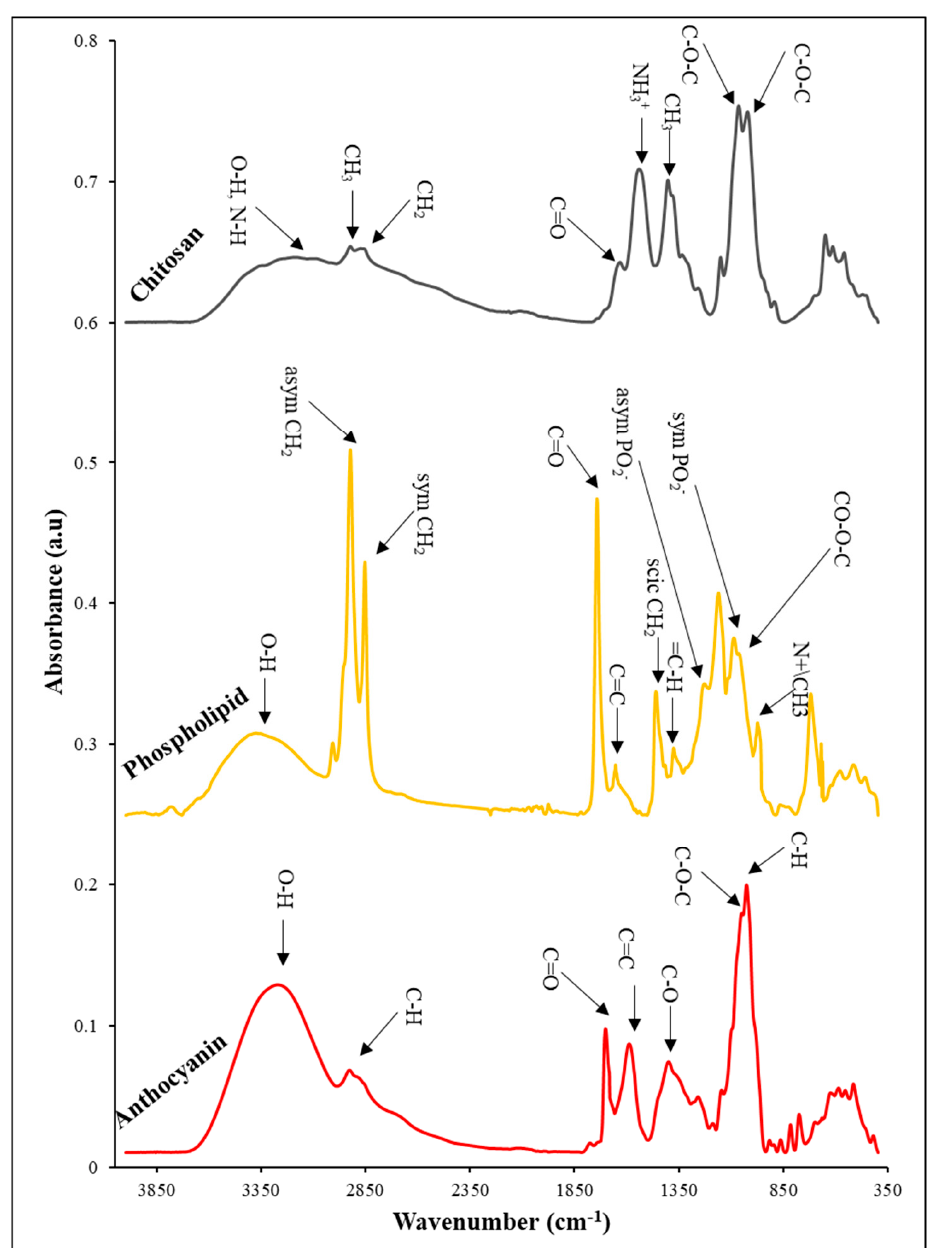
Figure 5. FTIR spectrum of anthocyanin, phospholipid, and chitosan.